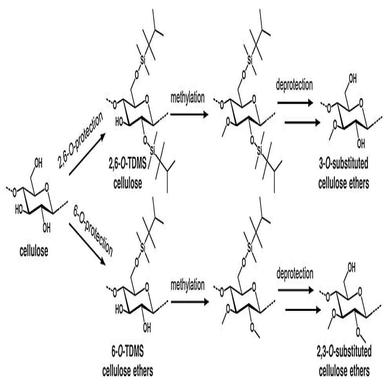
Reaction scheme for the regioselective synthesis of 3-O-substituted and 2,3-O-substituted methylcelluloses.